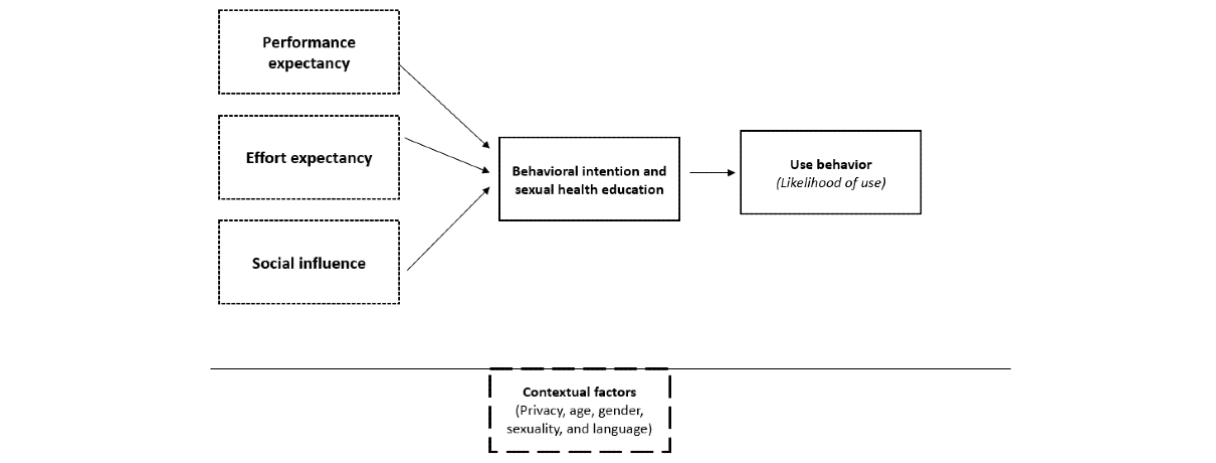
Figure 1. Adapted Unified Theory of Acceptance and Use of Technology model.